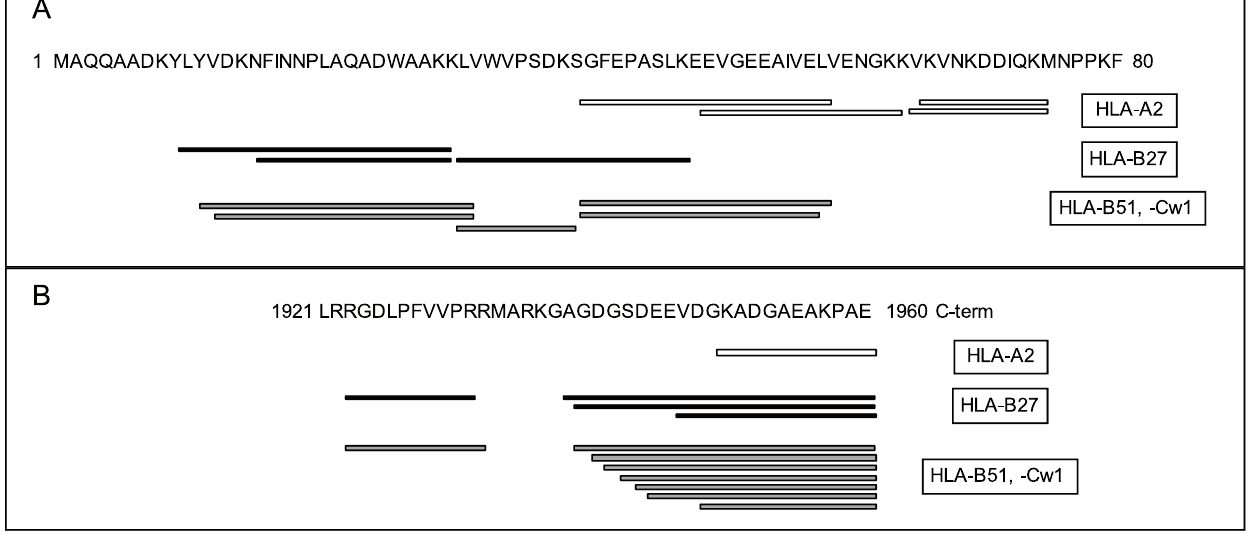
Figure 1. Naturally processed peptides from myosin heavy polypeptide 9 identified by mass spectrometry. Diagram of identified ligands bound to HLA class I molecules in the first 80 (panel A) or last 40 (panel B) residues from myosin heavy chain 9 protein. Ligands specific for HLA-A2 (white boxes), -B27 (black boxes), and –B51 or –Cw1 (gray boxes) are depicted in the lower section of each panel.